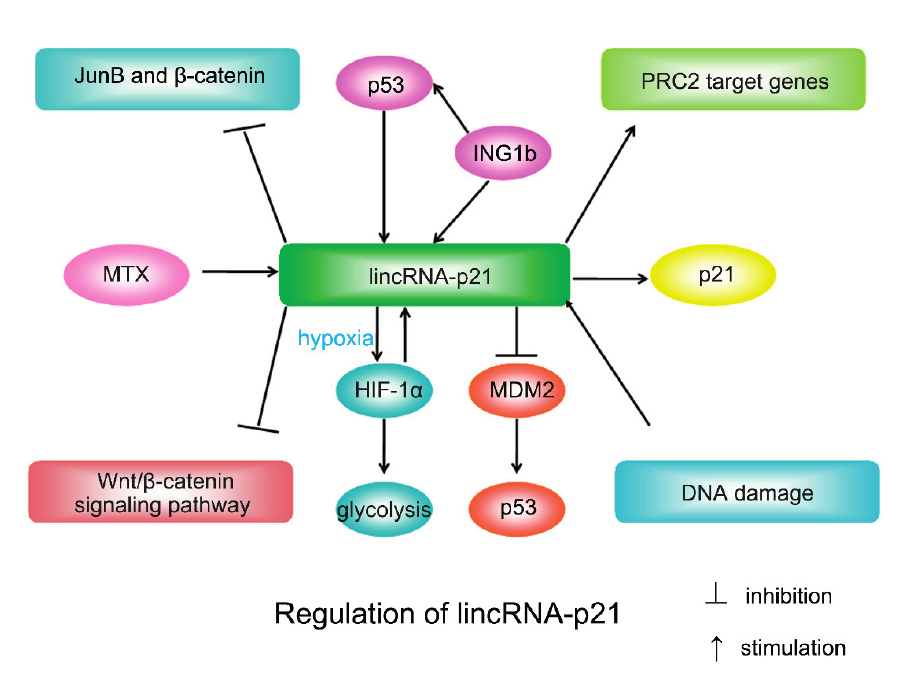
Figure 1. Overview of the known regulatory mechanisms for